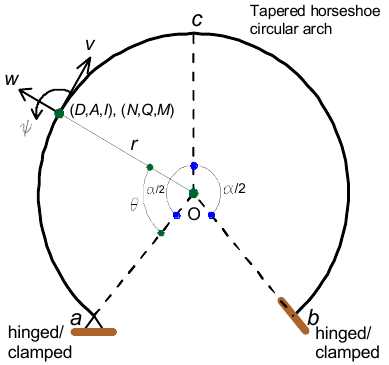
Figure 2. Geometry of tapered horseshoe circular arch.